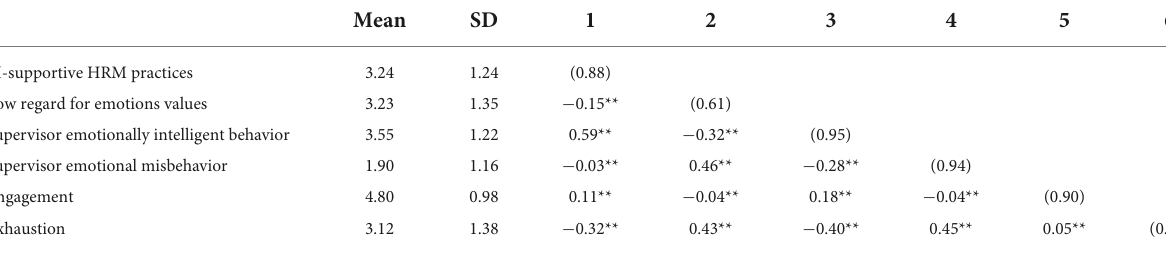
TABLE 4 Study 2–Descriptive statistics and zero-order correlations ( N = 12,375).